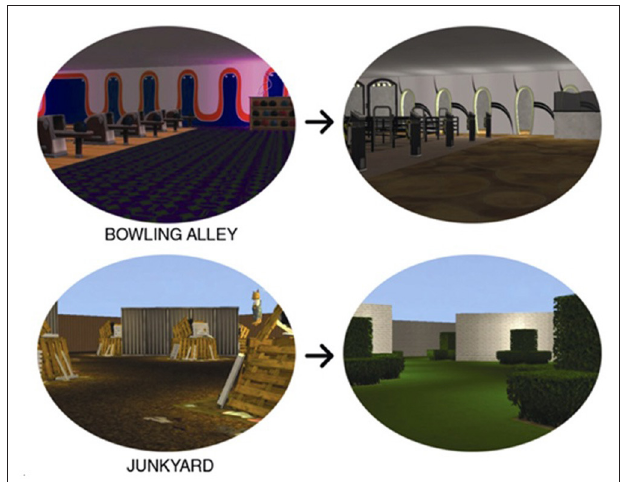
FIGURE 8 | Examining meta-memory with a spatial task. In this virtual reality task from the Cleary Lab (258), subjects can rate feelings of familiarity and deja vu after flying through spatially similar scenes. This is presently being used in the setting of SEEG to examine the anatomy and network activity associated with familiarity. It is also under development with contemporary virtual reality hardware and